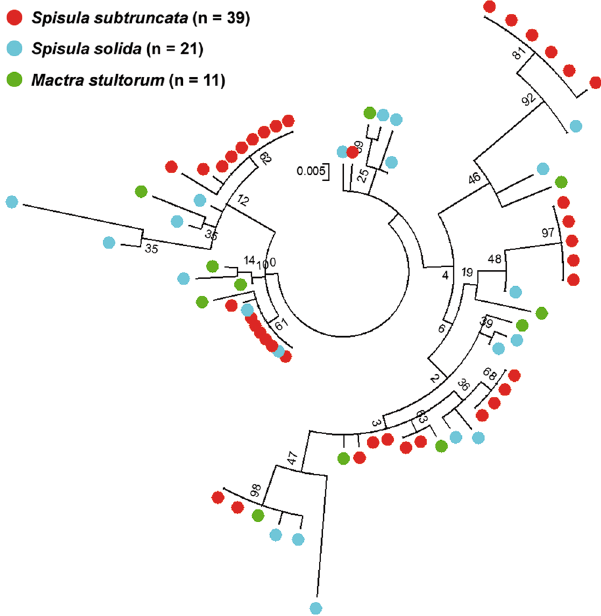
Figure 4. SSUsat maximum likelihood tree. Maximum likelihood tree built by Kimura 2-parameter model with Gamma distribution on the basis of the 71 SSUsat monomeric sequences isolated from Spisula subtruncata (39 monomers), Spisula solida (21) and Mactra stultorum (11) and 500 bootstrap replicates. The tree is based on the alignment shown in Supplementary Fig. 2. Numbers in internal nodes indicate bootstrap support